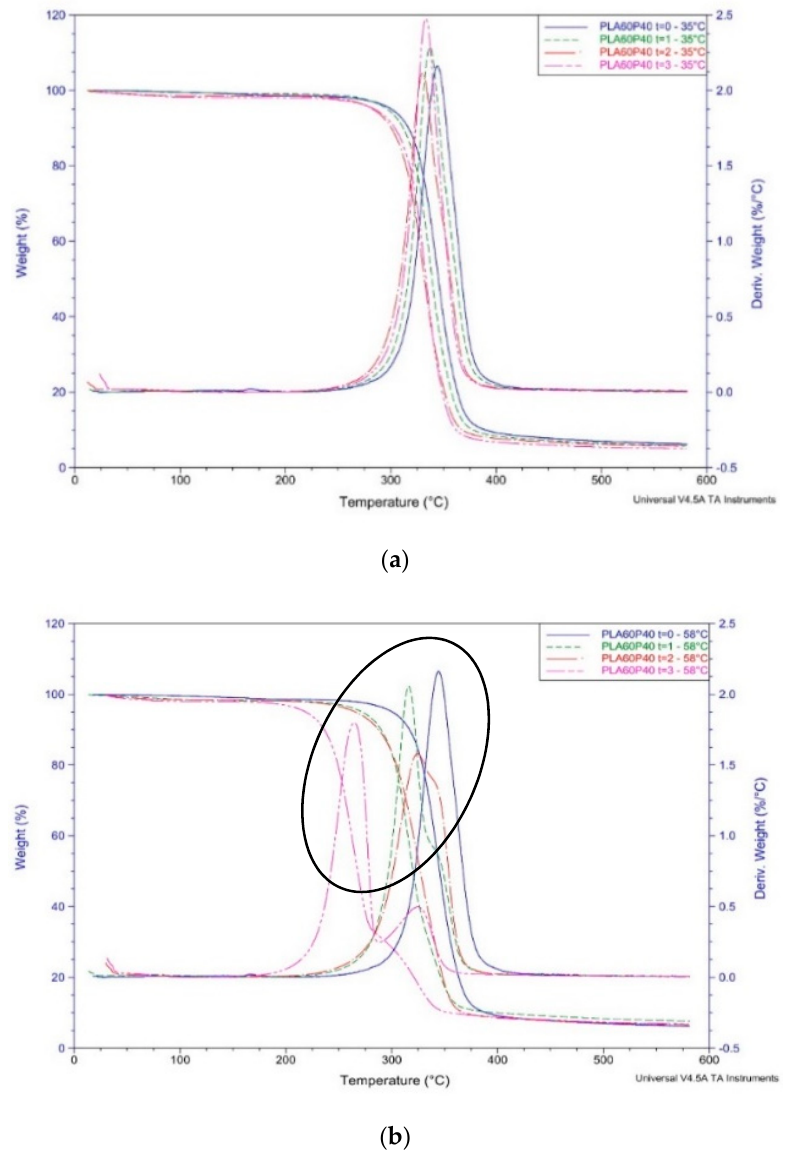
Figure 4. Mass loss and related peaks recorded in thermogravimetric (TG) and first order derivative of TG ascribed to the degradation of PLA60-P40 at month 0, 1, 2, 3 at 35 °C ( a ) and 58 °C ( b